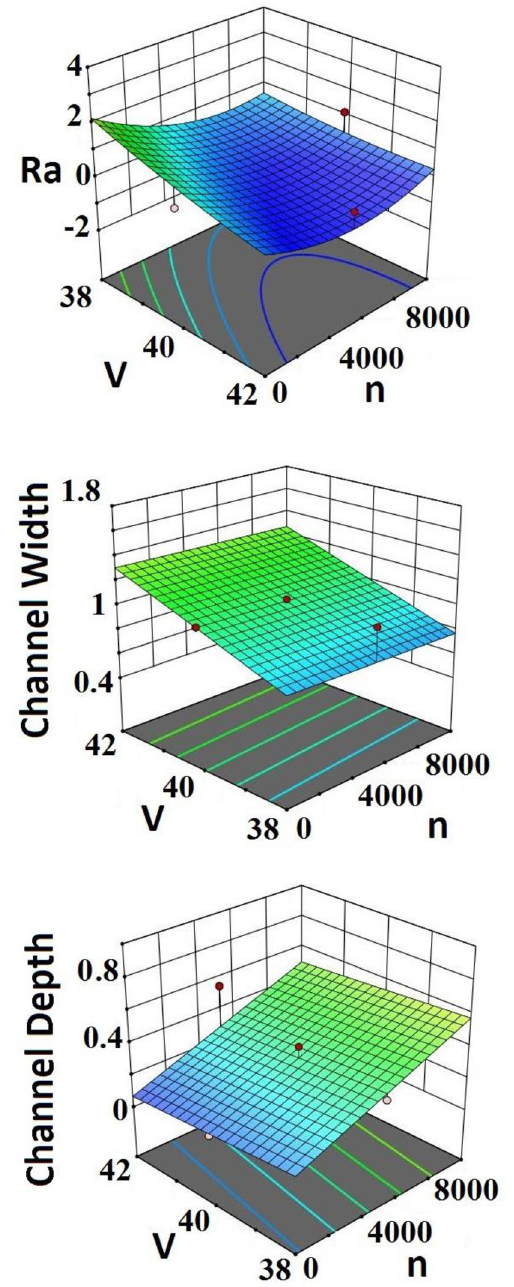
Fig. 17 3D diagram of effect of inputs on Ra and channel dimen- • The effect of ultrasonic vibration on the surface quality of PDMS machined surface using ECDM was not inves- tigated in this research.